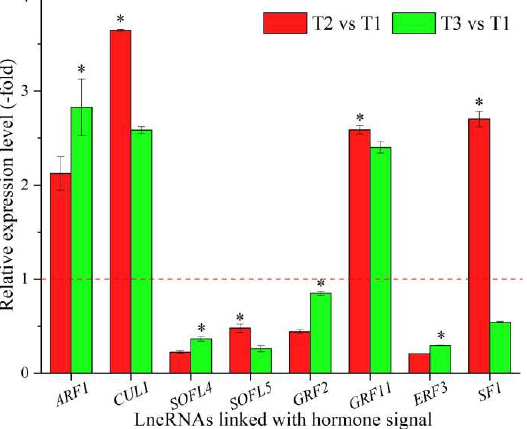
Figure 6. The expression levels of coexpressed mRNAs of lncRNAs linked with biosignaling in A.